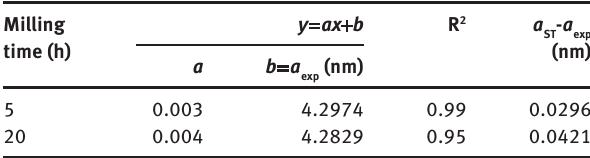
Table 3: Calculation of lattice parameter of TiC after 5 and 20 h of and a : experimental and standard lattice parameter, milling ( a exp ST